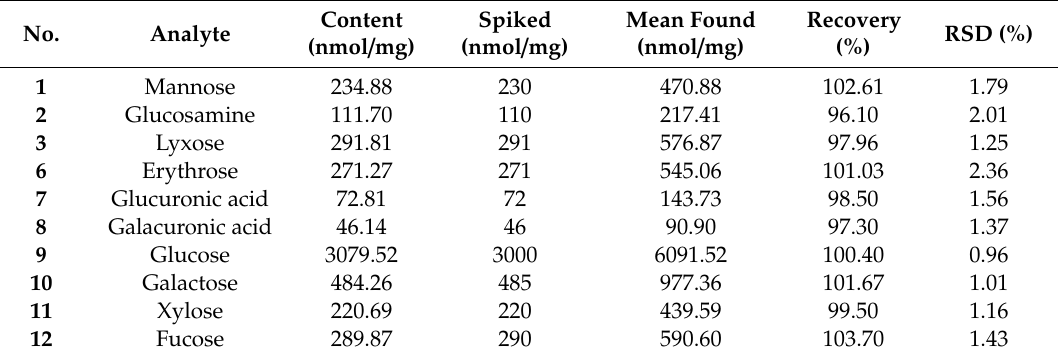
Table 4. Recovery analysis of 10 monosaccharides of PPS ( n =